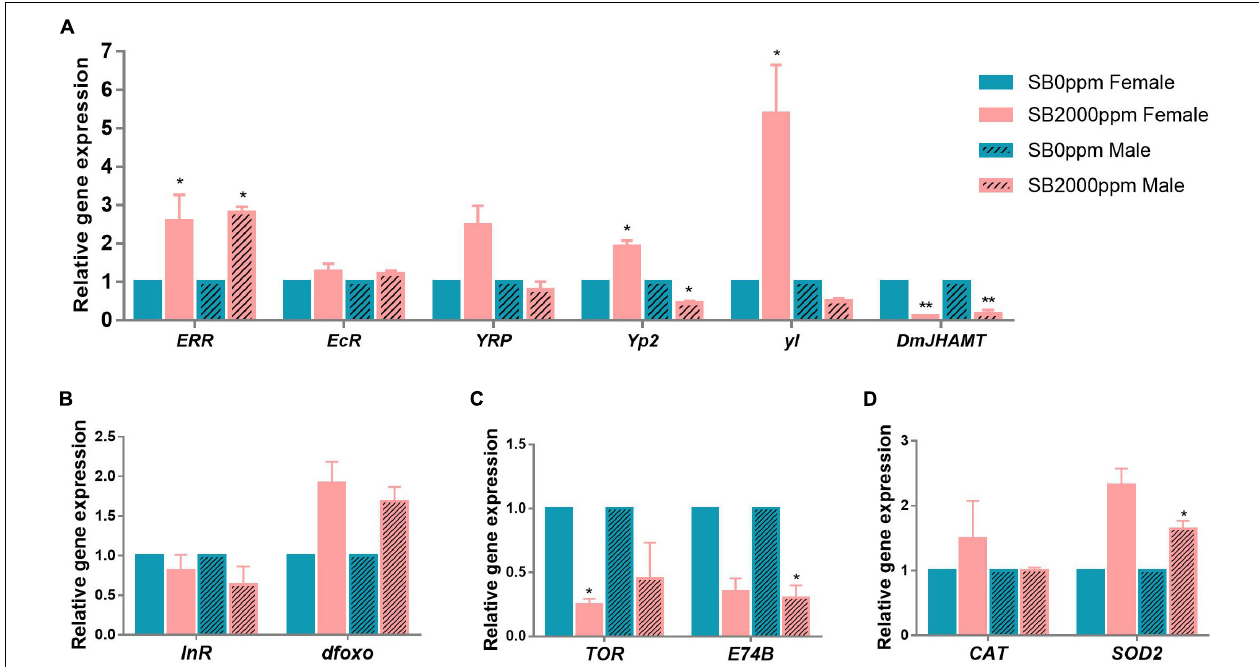
FIGURE 8 | Gene expressions of flies fed with SB. (A) Hormone-related genes. (B) IIS pathway-related genes. (C) TOR pathway-related genes. (D) Antioxidant enzymes-related genes. The significance was achieved by comparing SB with the control groups. * p < 0.05, ** p <